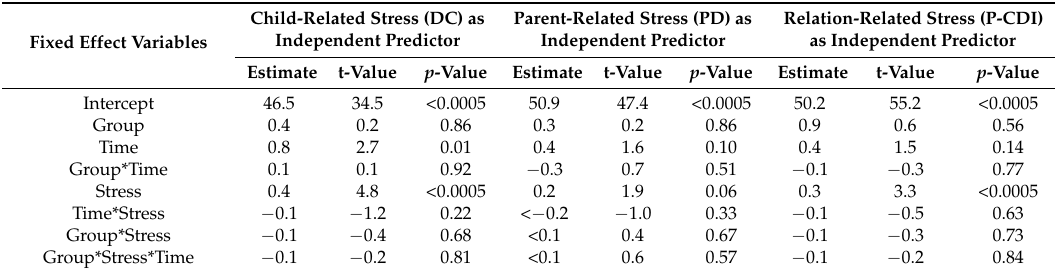
Table A2. Social behavior problems and stress, maternal